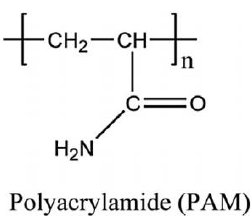
Figure 4—Molecular structures of polyacrylamide (PAM).